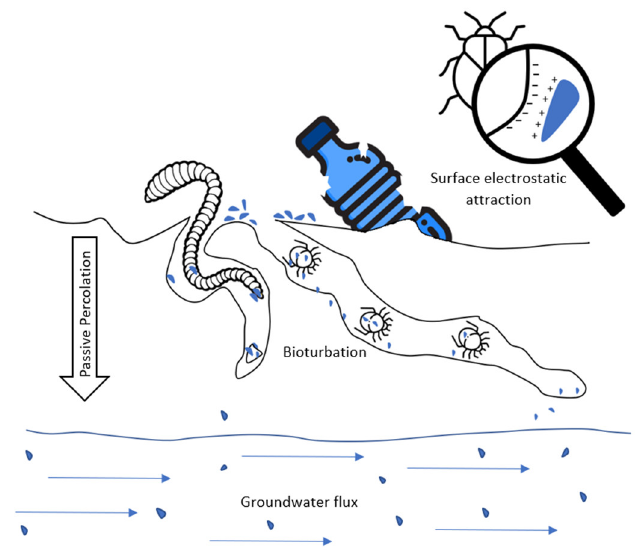
Figure 5. Vectors of microplastic particles for groundwater reservoirs.